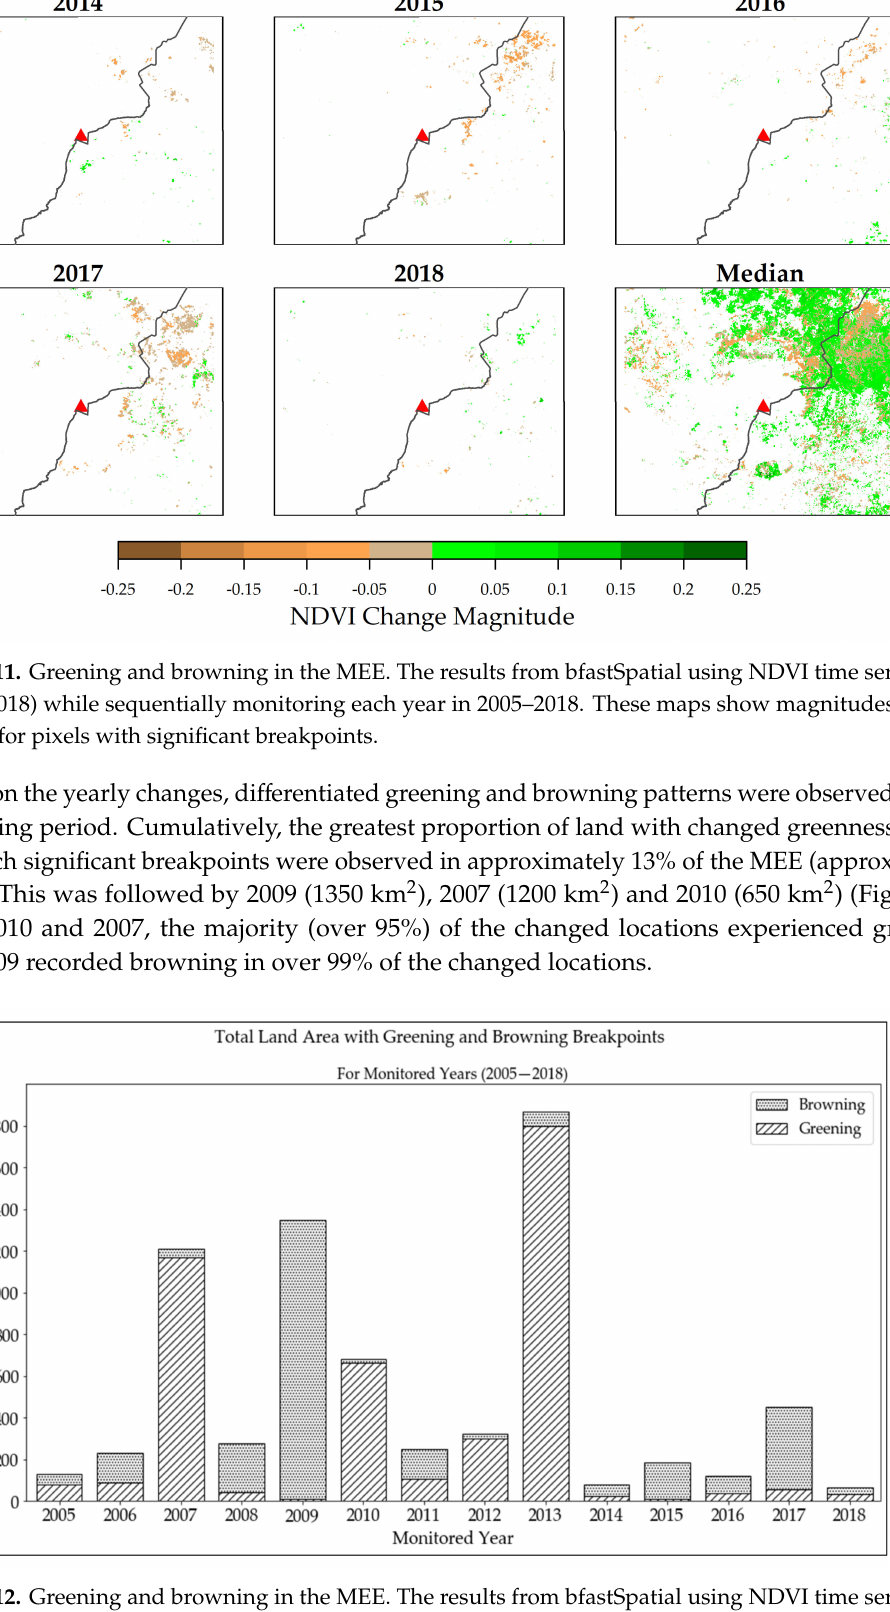
Figure 12. Greening and browning in the MEE. The results from bfastSpatial using NDVI time series (2001–2018) while sequentially monitoring each year in 2005–2018. The graphs show the total area of land that experienced greening and browning for each monitored